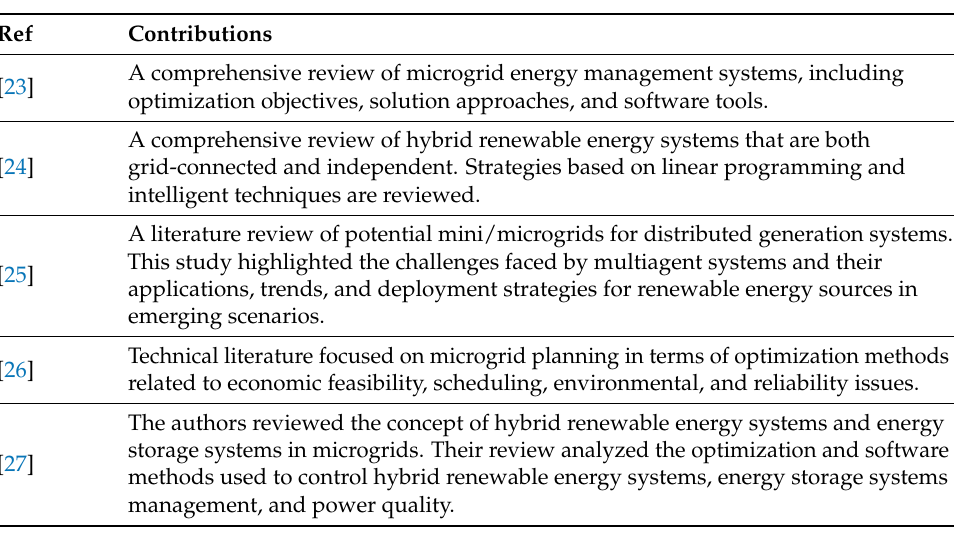
Table 1. Existing reviews related to the energy management system of